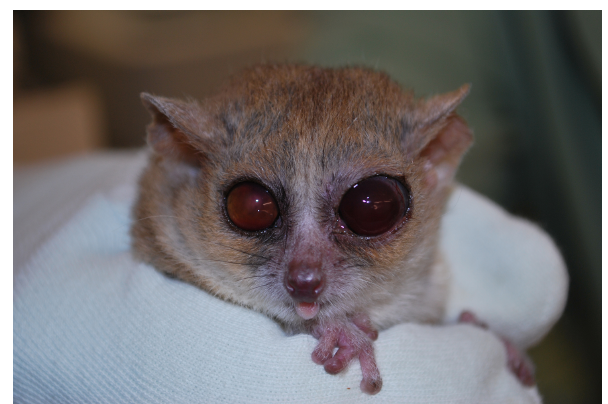
Figure 6. Eight-year old individual (same individual as in Fig. 5) with an enlarged left eye